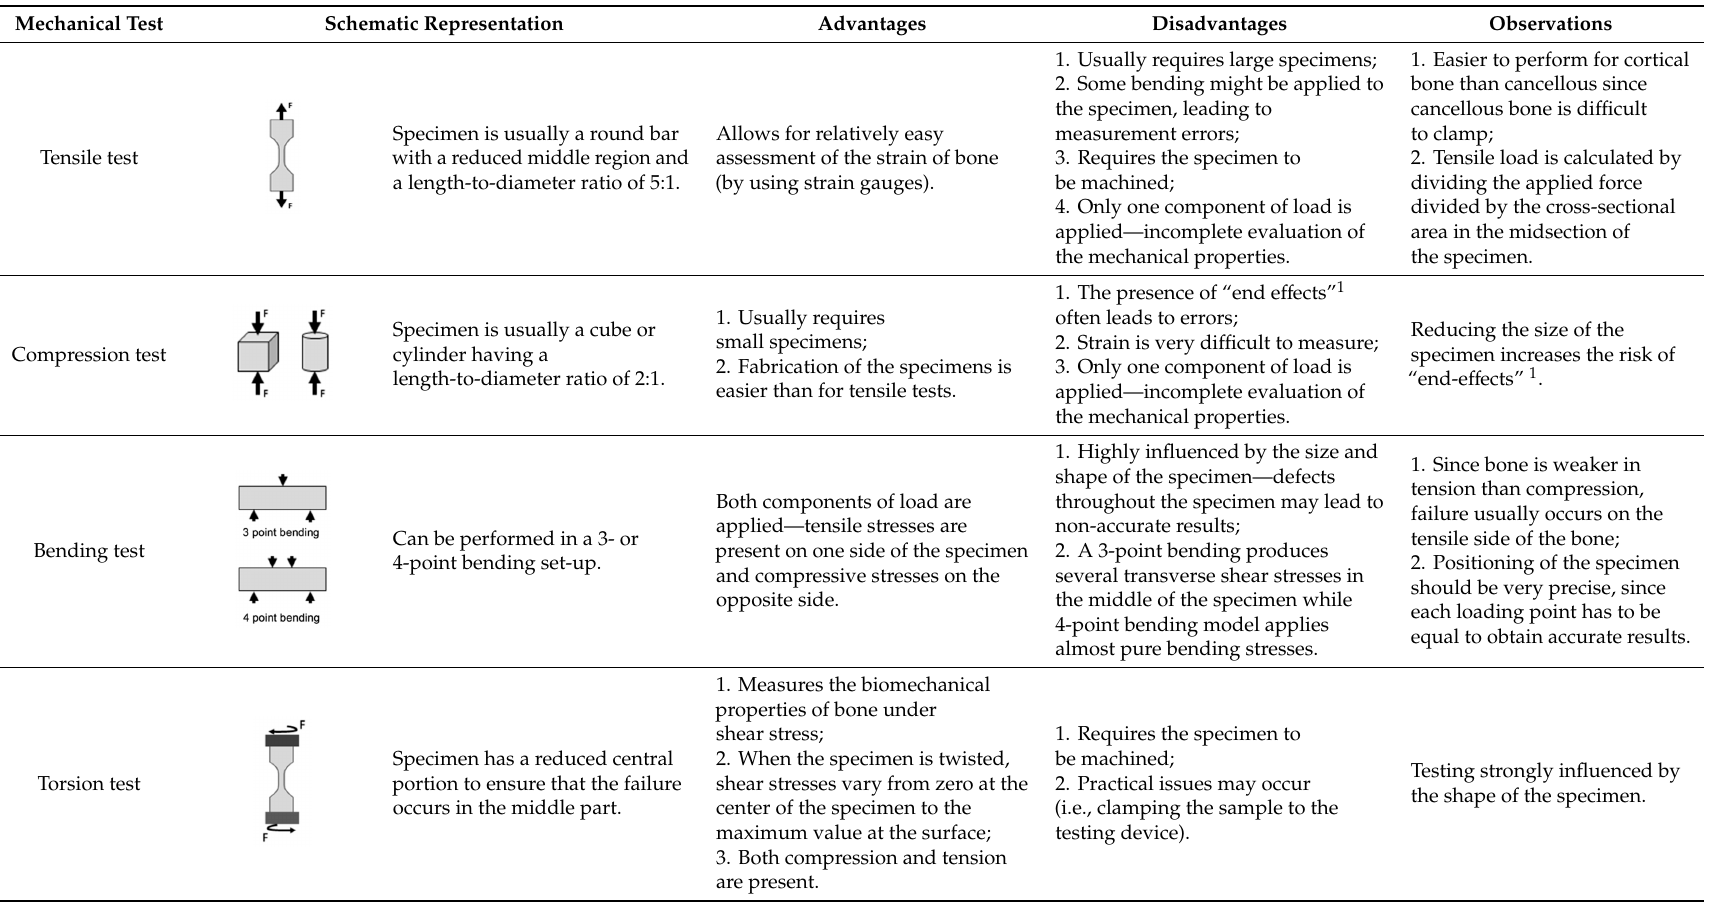
Table 5. Types of ex-vivo mechanical tests for the evaluation of the biomechanical properties of explanted bone specimens.